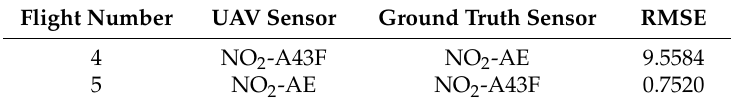
Table 2. Stage B of Phase 3 Validation Results.